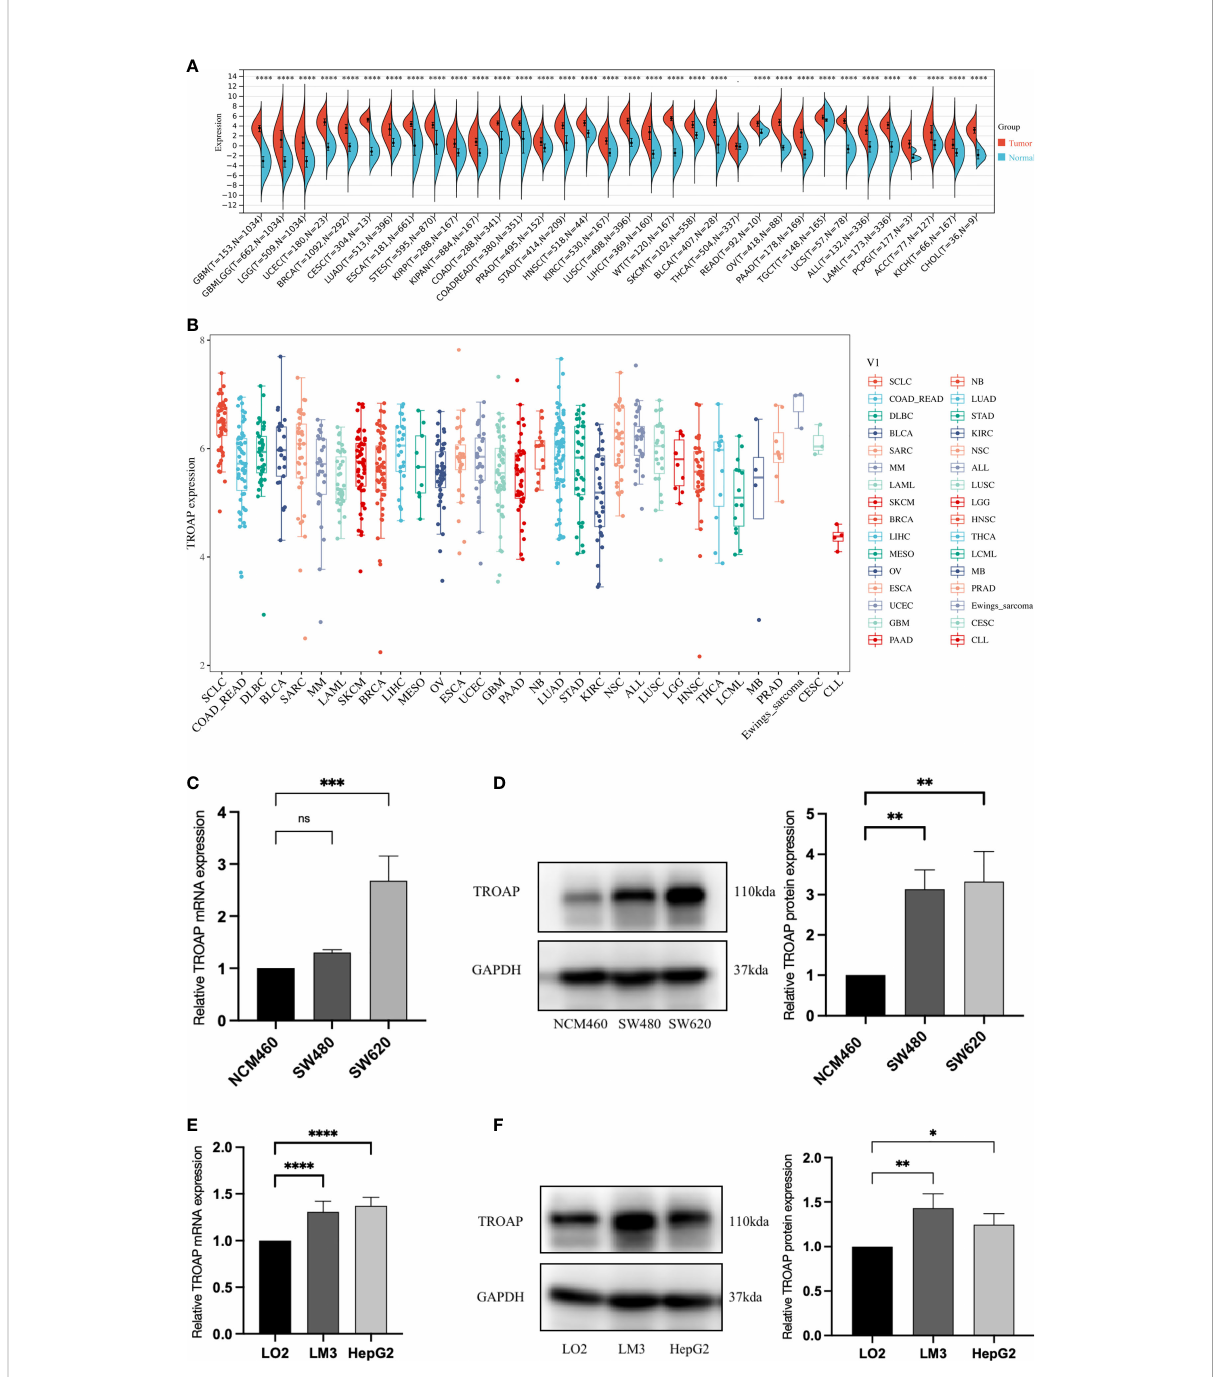
FIGURE 1 Differential transcriptional expression of TROAP. (A) TROAP expression in tumor tissues and paired normal tissues in various cancers according to the RNA sequencing data from the TCGA database via the SangerBox online tool. (B) The transcriptional expression of TROAP in different cancer cell lines was analyzed by the CCLE database. (C) The results of qRT-PCR showed that the mRNA levels of TROAP in colorectal cancer (CRC) cells (SW480, SW620) were signi fi cantly elevated compared with normal colorectal mucosa cells (NCM460). (D) The results of Western blotting showed that the protein expression level of TROAP was upregulated in CRC cells compared to the NCM460 cells. (E) The results of qRT-PCR demonstrated that the mRNA levels of TROAP were up-regulated in hepatocellular carcinoma (HCC) cells (HCC-LM3, HepG2) compared to the normal liver cells (LO2). (F) The protein expression levels of TROAP in LO2 cells and HCC cells (Western blotting). TROAP protein was much higher in HCC cell lines than that in LO2 cells. All *: P < 0.05, **: P < 0.01, ***:P < 0.001, ****:P < 0.0001, and ns: no signi fi